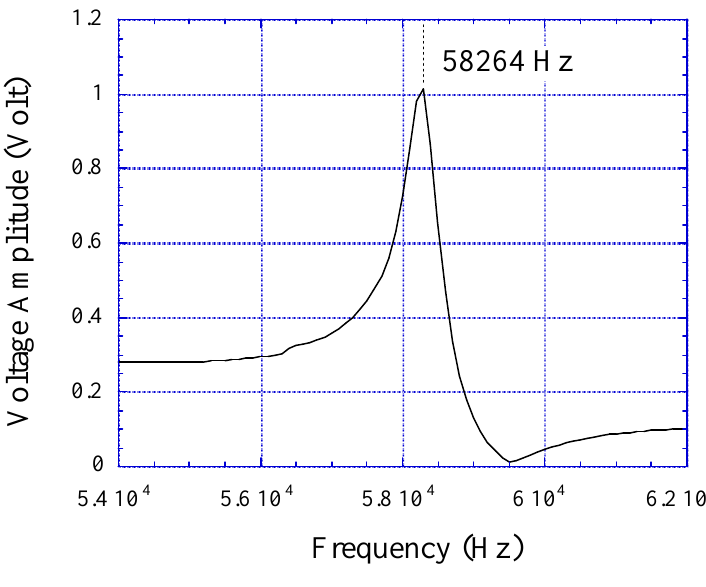
Figure 5. Illustrative frequency spectrum of a magnetoelastic ribbon in